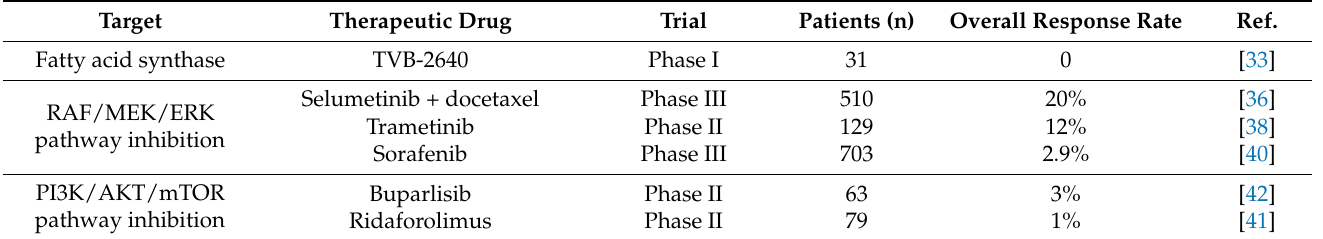
Table 2. Indirect KRAS inhibition—targeting KRAS- regulated